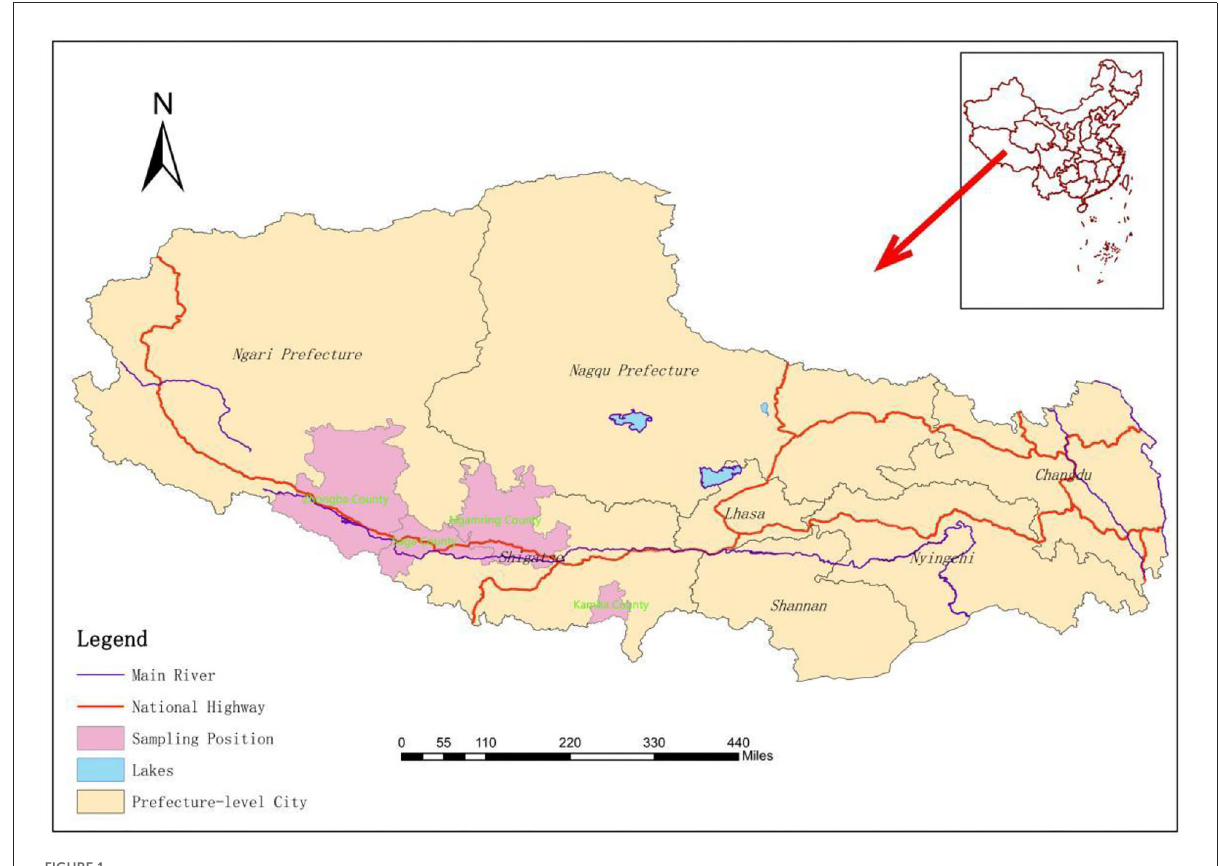
FIGURE1 Geographic origin of the livestock detected in the